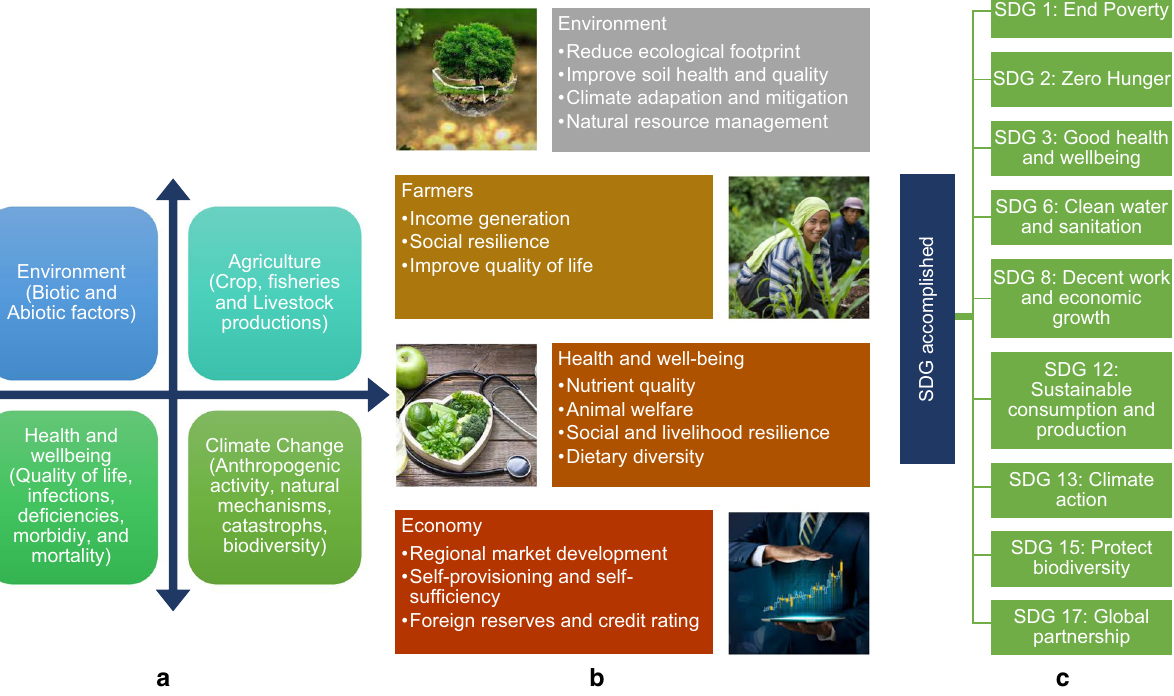
Fig. 6 Complex relationships in building transdiciplinary holistic food system resilience. a Interacting components, b Benefits enjoyed and c SDG accomplished. Source